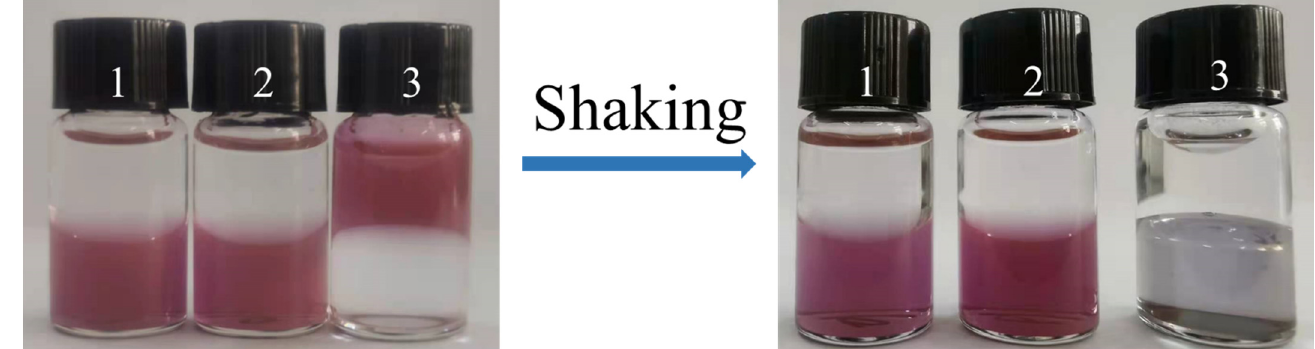
Figure 2. Images of the mixture of thee Au NP colloid and different organic solvents before and after shaking (1: n-hexane, 2: cyclohexane, 3: chloroform).